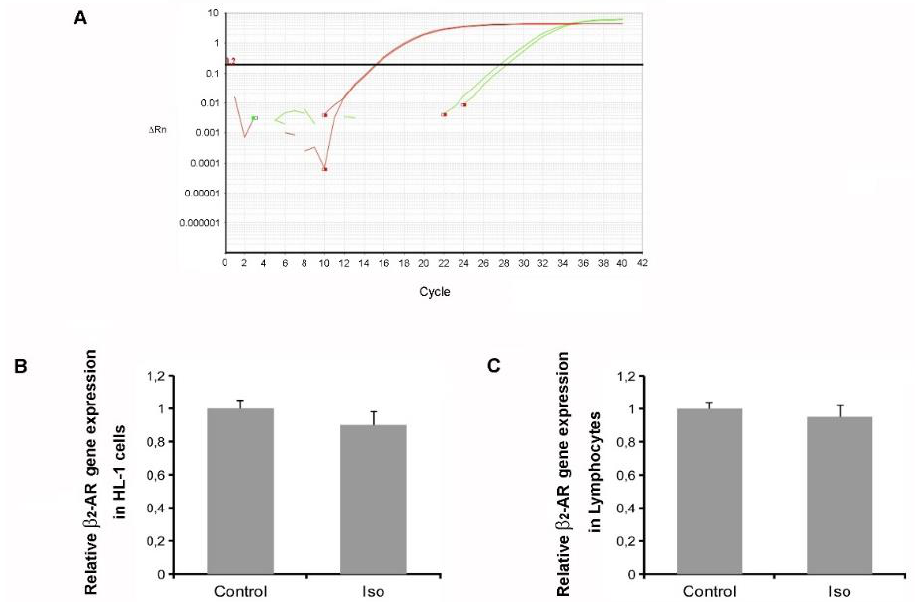
Figure 3. Isoproterenol does not affect β 2 -AR mRNA levels in both HL-1 cells and lymphocytes. ( A ) Representative amplification plot for TaqMan qPCR using the β 2 -AR assay probe in human lymphocytes (red line, reference gene; green line, β 2 -AR gene). ( B ) β 2 -AR gene expression in HL-1 cells treated with isoproterenol (iso) (1 µ M) for 3 h. For each group, summary data of three independent experiments run in duplicate are shown. ( C ) β 2 -AR gene expression in lymphocytes treated with isoproterenol (1 µ M) for 3 h. For each group, summary data of three independent experiments run in duplicate are shown.